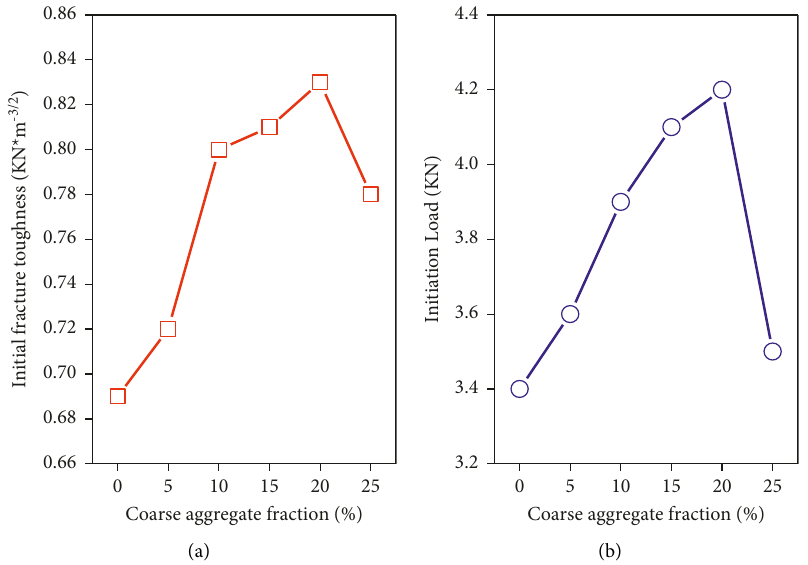
Figure 5: Initiation load and initial fracture toughness of the coarse aggregate interlocking concrete.